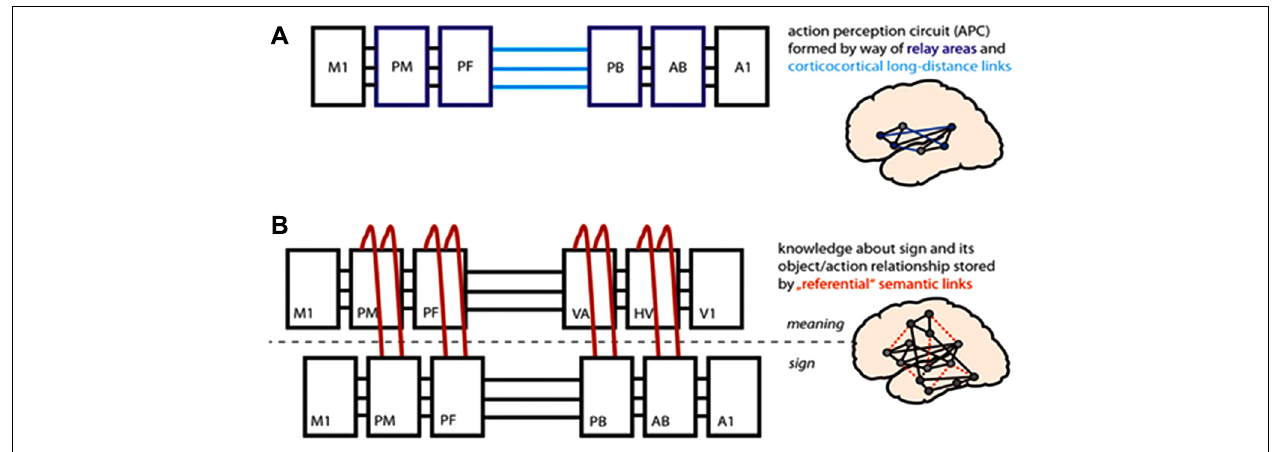
forms by way of long-distance links between APCs for word forms and concepts; the illustrated conceptual circuit involves neurons in dorsolateral M1, PM, and PF motor/executive cortex and inV1 (primary visual), HV (higher visual), andVA (visual association) cortex in the ventral object processing stream.The APC model predicts that lesions in motor areas (M1, PM) or disconnection of these regions leads to disintegration of the mechanisms for language processing and especially impacts on action-related